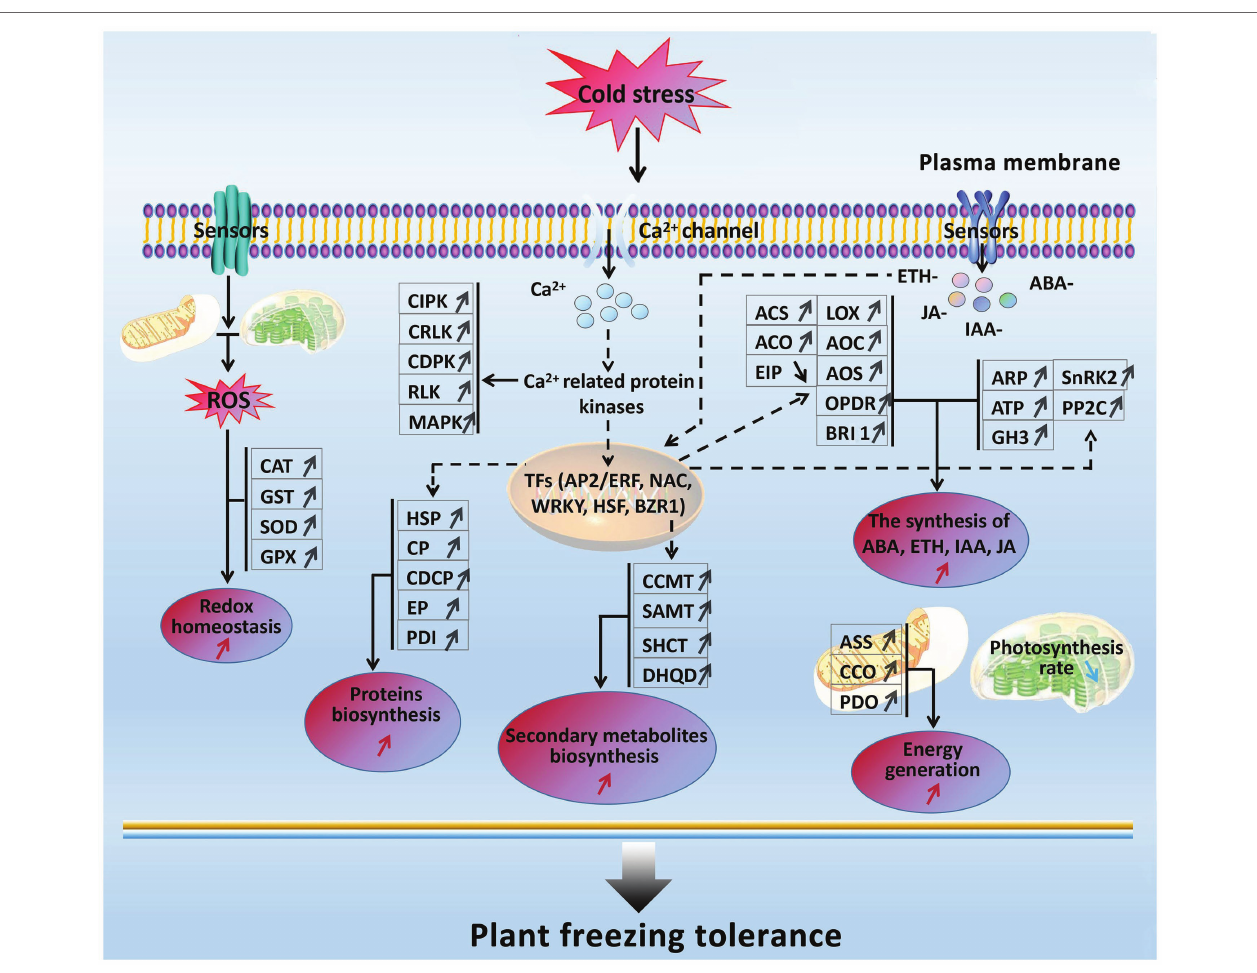
FIGURE 8 | A presumed model for freezing tolerance mechanism in developing rapeseed leaves under freezing stress. The freezing-responsive genes and proteins up-regulated are marked by “ ↑ ,” and those down-regulated are marked by “ ↓ .” The enhanced metabolic pathways and cellular processes are marked with the red “ ↑ ,” while the reduced ones are marked with the blue “ ↓ .” Dashed arrows indicate possible